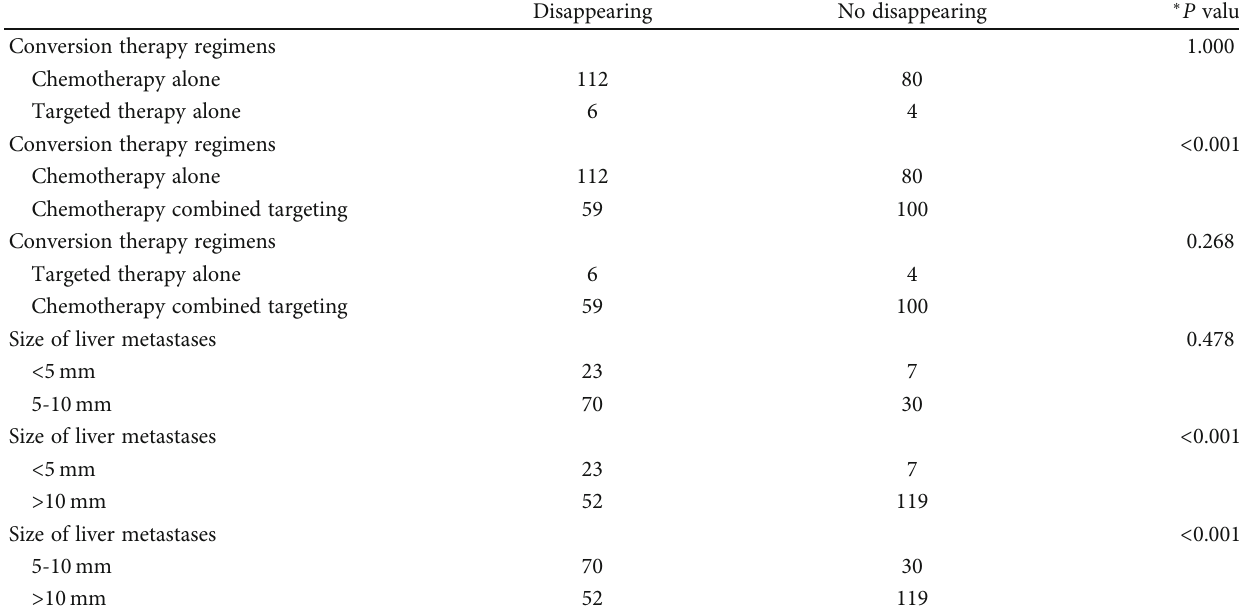
Table 4: The correlation of di ff erent factors and DLM.